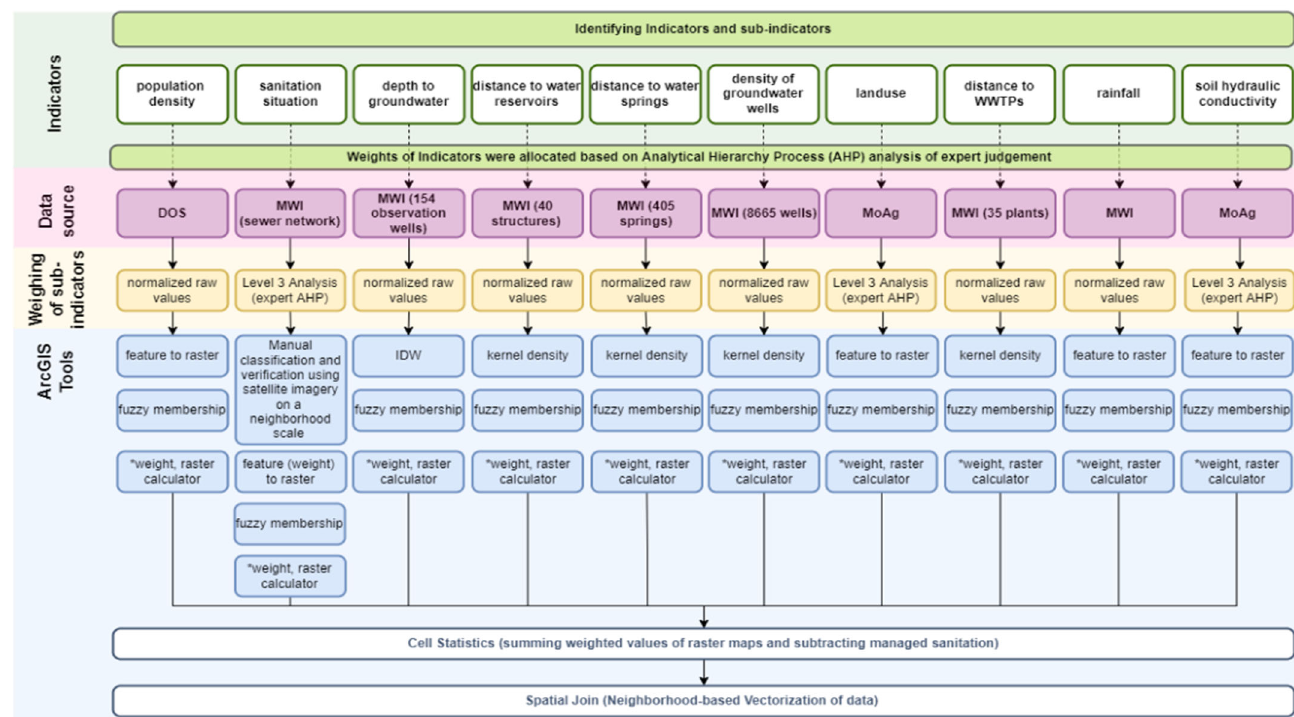
Figure 3. Methodology of detailed spatial analysis of indicators.